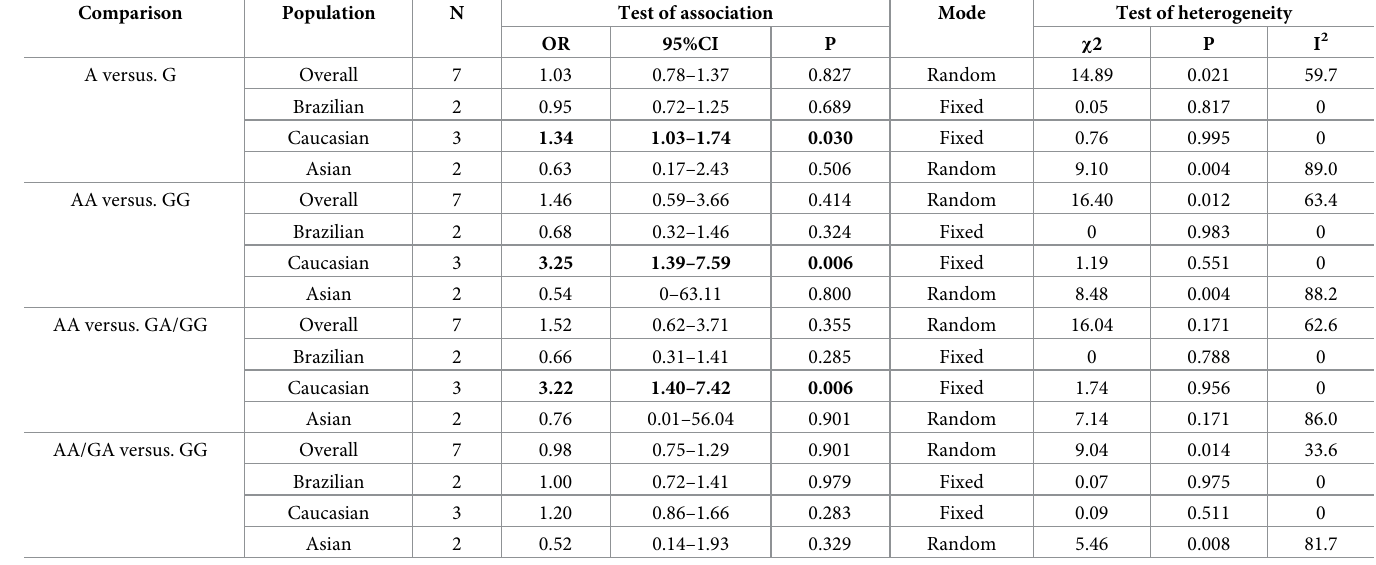
Table 2. Meta-analysis of the COL3A1 rs1800255 polymorphism and POP